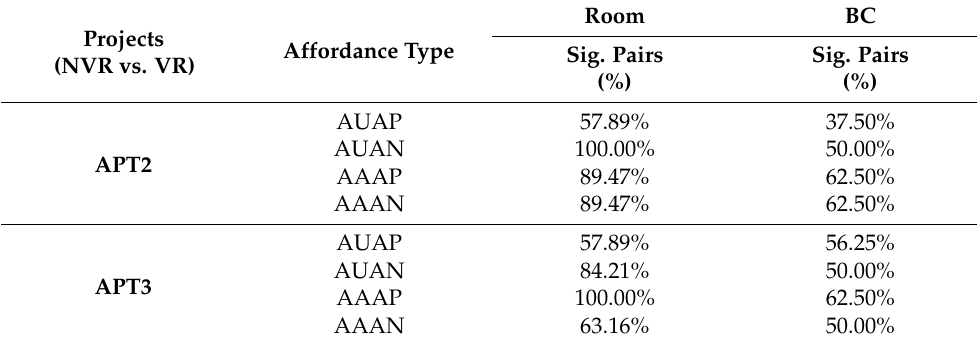
Table 18. Percentages of affordance pairs that have a significant p -value in the APT project.